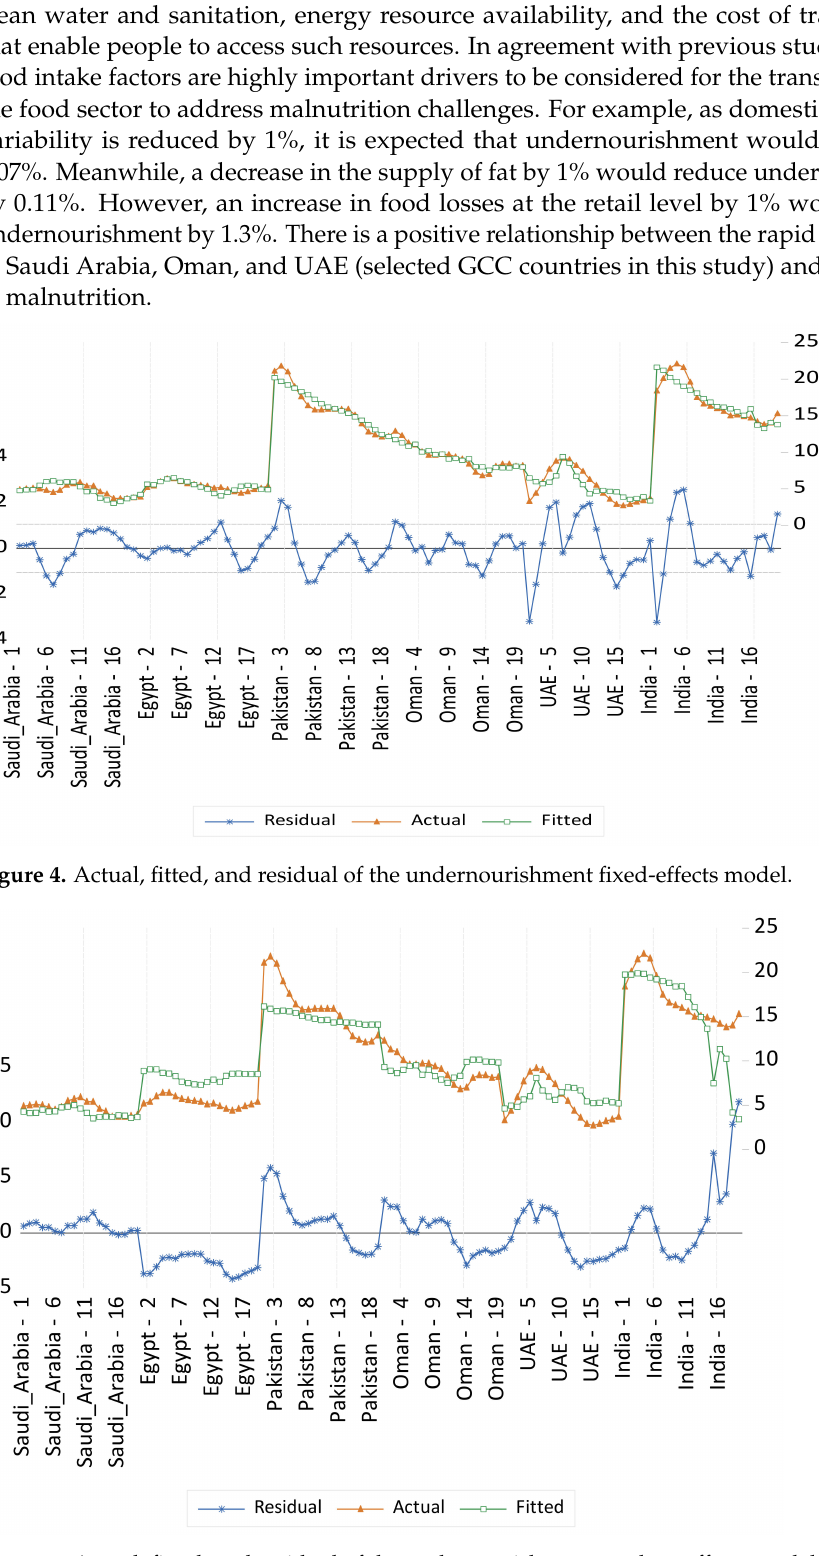
Figure 5. Actual, fitted, and residual of the undernourishment random-effects